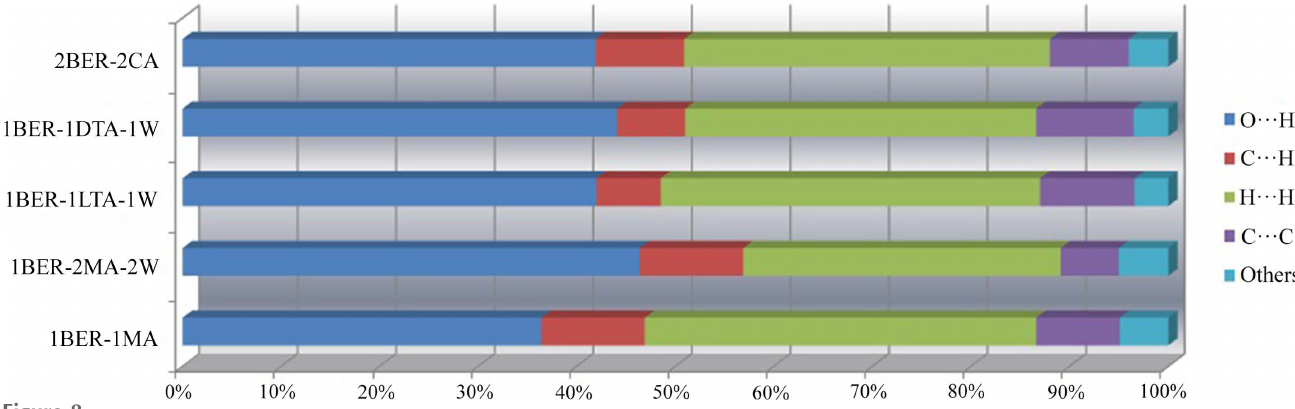
[shortest centre-to-centre